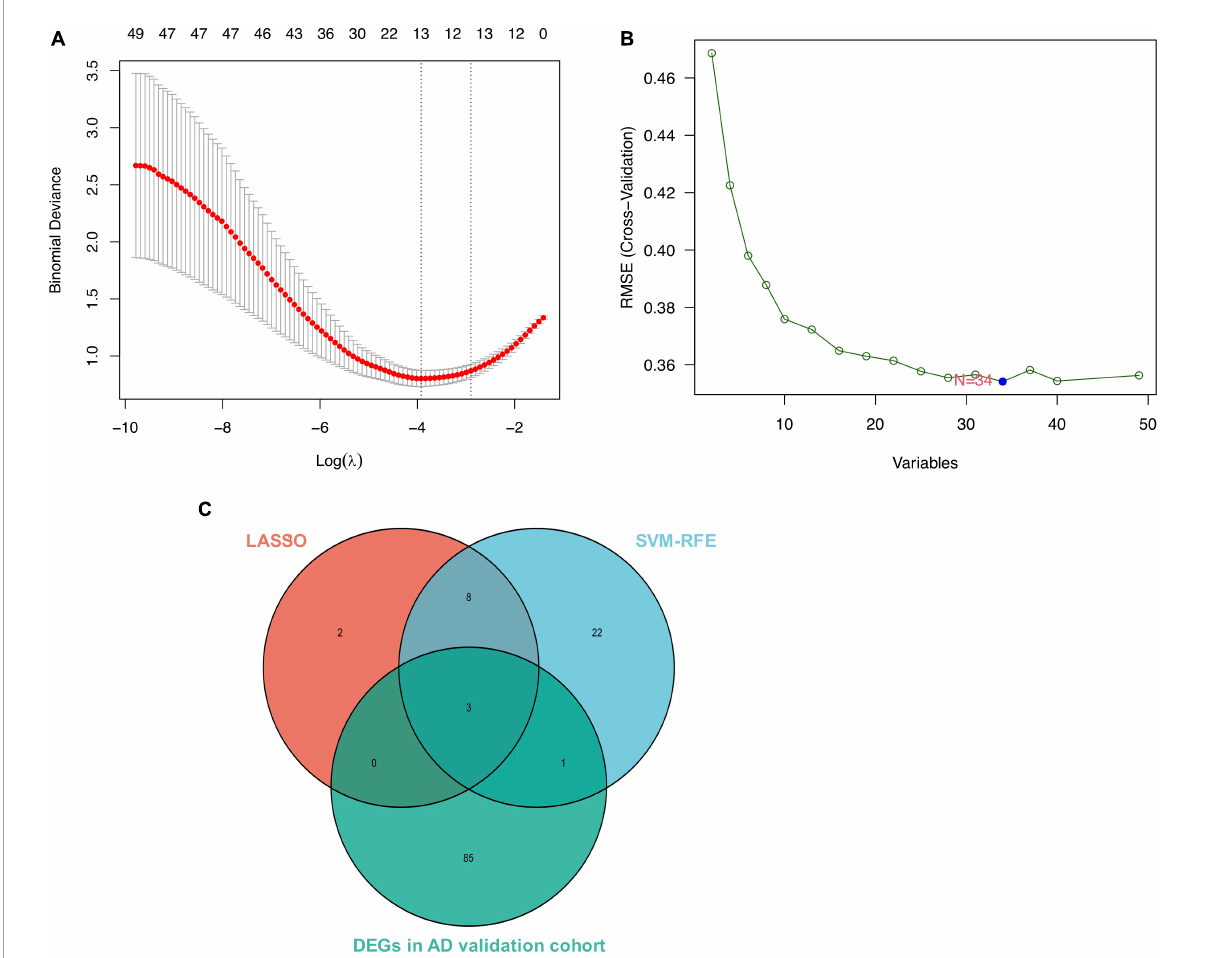
FIGURE4 Screen for potential biomarkers of Alzheimer’s disease (AD) diagnosis. (A) Identified genes using Least Absolute Shrinkage Selection Operator (LASSO) algorithm. (B) The optimal feature biomarkers selection via support vector machine-recursive feature elimination (SVM-RFE) algorithm. (C) Venn diagram displaying one diagnostic marker intersected by LASSO, SVM-RFE algorithms, and differentially expressed genes (DEGs) in AD validated